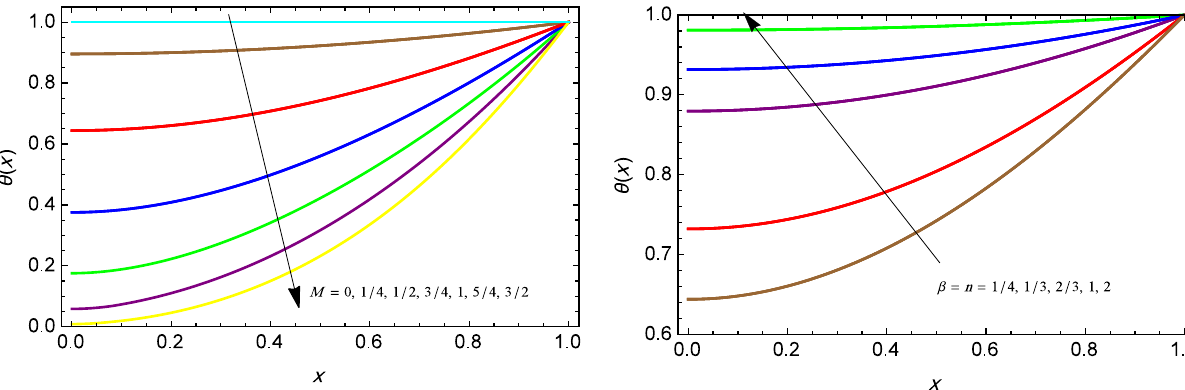
Figure 1: Diagram of θ x ( ) versus x for temperature distributions with n β 1 = = . 4